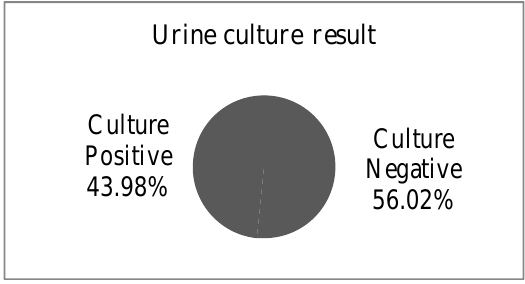
Table 1: Urine culture result